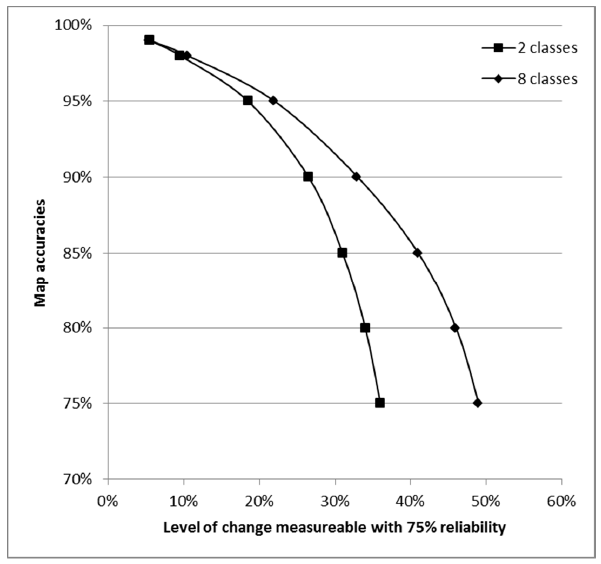
Figure 3. The level of change that can be measured with 75% reliability when mapped using pairs of maps with 2 and 8 classes and with map-accuracies ranging from 75%–99%; after [31].